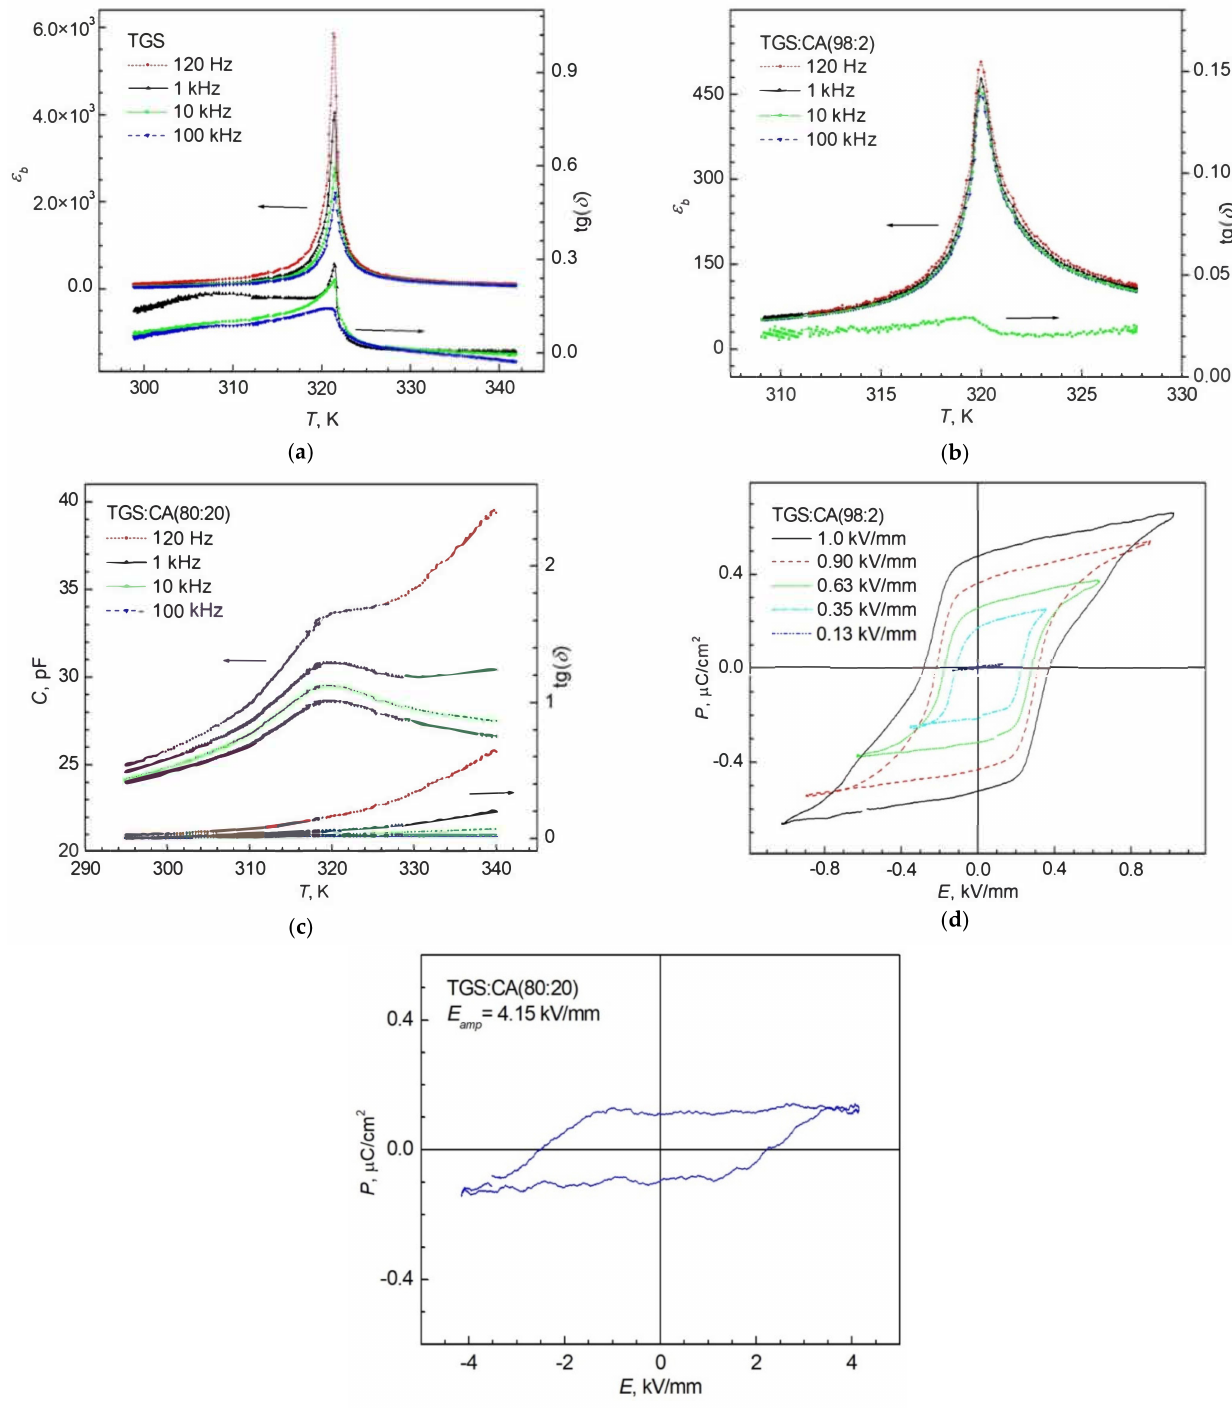
Figure 11. Temperature dependences of permittivity ε b and tg( δ ) in ( a ) TGS and ( b ) TGS:CA (98:2) crys- tal. ( c ) Dependence of capacitance C and tg( δ ) in TGS:CA (80:20) film. ( d ) Dielectric hysteresis loops for different values of electric field amplitude E amp (indicated in ( d )) at RT in a TGS:CA (98:2) crystal. ( e ) Dielectric hysteresis loop in TGS:CA (80:20) film for electric field amplitude E amp = 4.15 kV/mm at RT. Figure 11c,e show the temperature dependence of the capacitance C , and the dielectric hysteresis loop in the TGS:CA (80:20) film, measured using an interdigital electrode